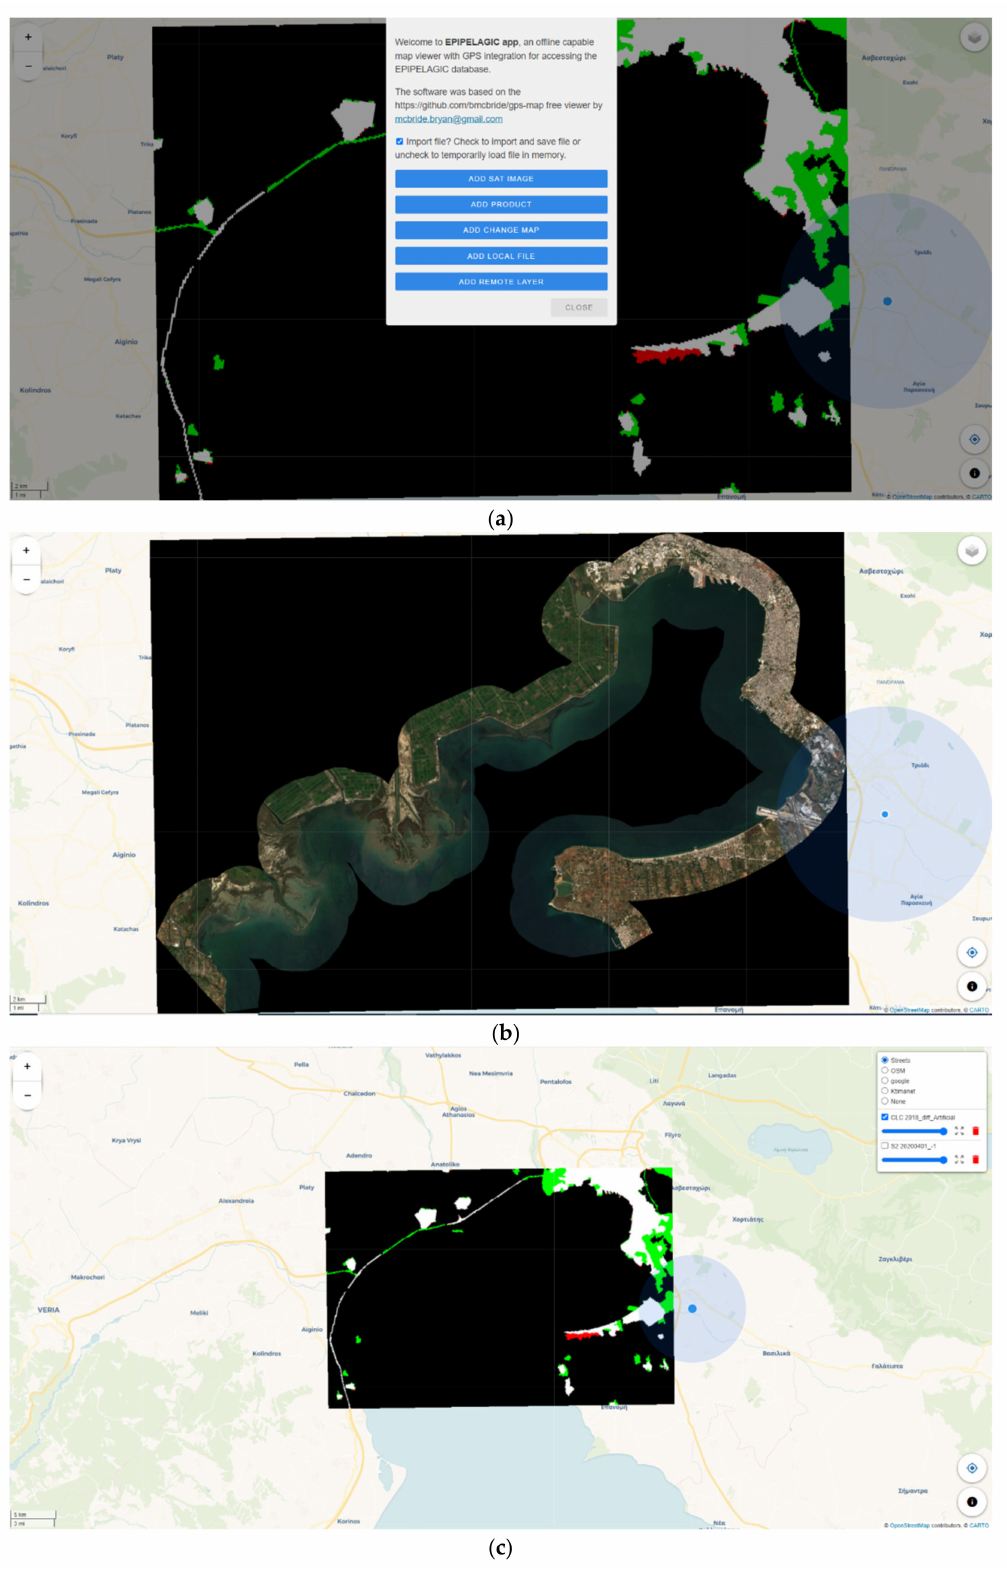
Figure 20. Preliminary version of WebGIS Interface: ( a ) User Menu ( b ), RGB image composite from Sentinel-2, ( c ) Urban area change map between years 1990 and 2018 (green: gain, red: loss, white: no change). The layer widget for selecting viewing options for background/foreground layers is also